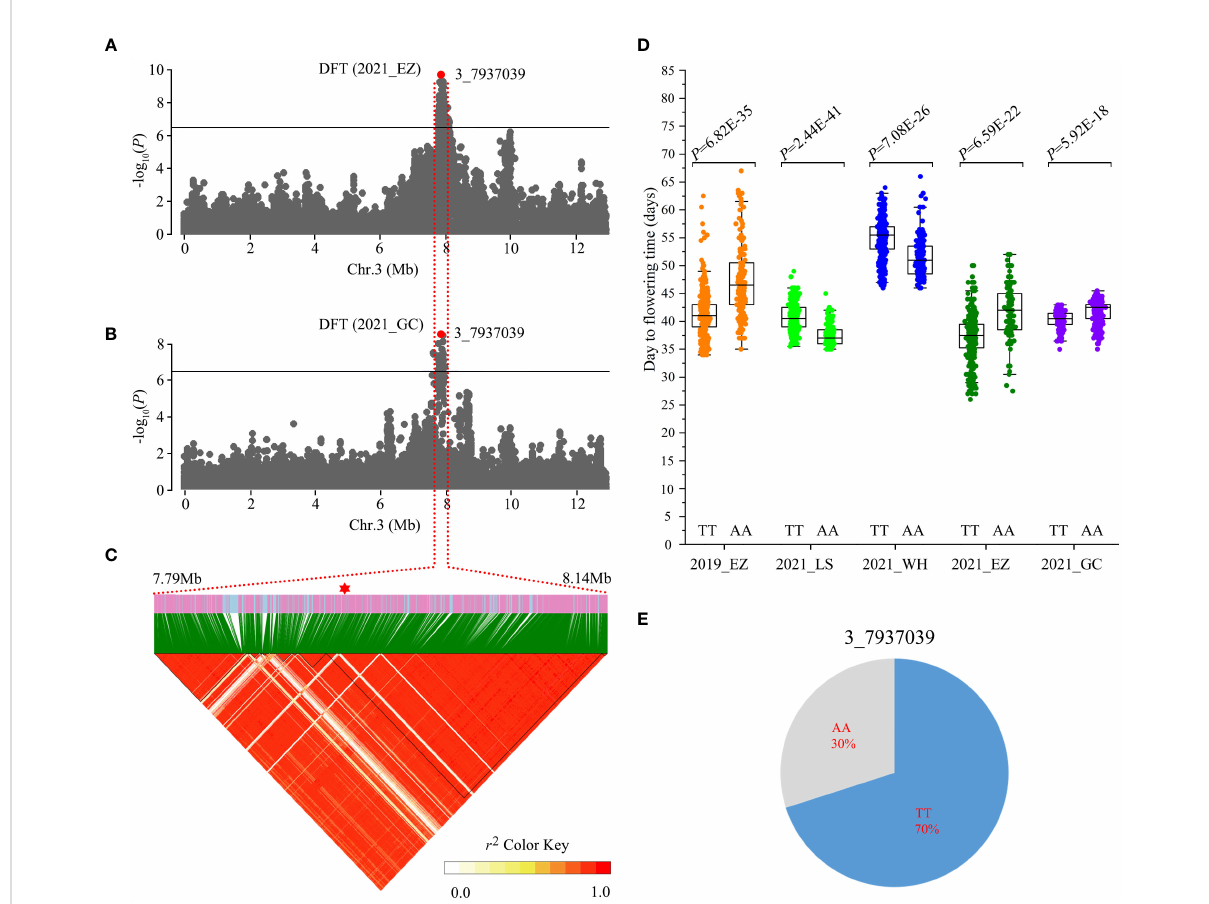
FIGURE 3 Identi fi cation of Chr3_7937039 fl owering time loci. (A, B) Local Manhattan plots showing the number of days to fl owering time (DFT) in the 2021_EZ (A) and 2021_GC environments (B) . Horizontal solid lines indicate the signi fi cance threshold ( P < 3.87E-07, – log 10 P = 6.41). The red dot indicates the peak SNP (3_7937039, T/A). (C) Linkage disequilibrium (LD) heatmap surrounding the peak SNP. (D) Box plots of DFT between the AA and TT alleles in different environments. Statistical signi fi cance for each environment was determined by a two-tailed t -test. (E) Genotype frequencies at the 3_7937039 SNP in the 558